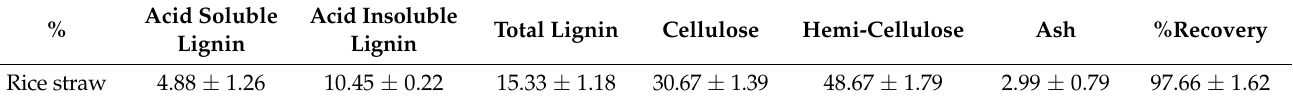
Table 2. Biomass composition of rice straw.